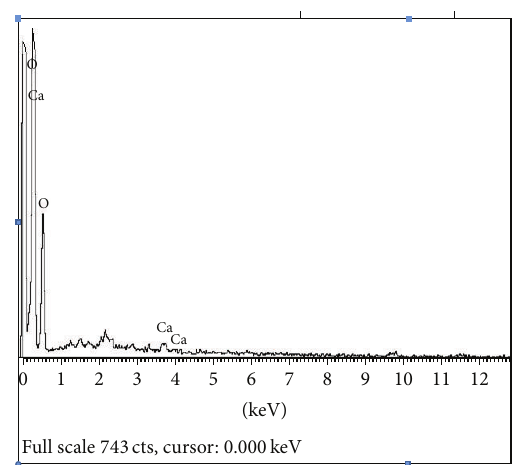
Figure 2: EDS curve of tea waste.